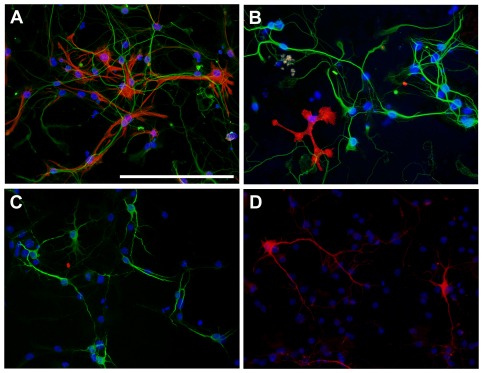
Cellular composition of neuron-astrocyte cultures.Composite fluorescence photomicrographs of neuron-astrocyte cultures that were immuno-stained with A–C) the neuronal marker MAP-2 (green) together with A) astrocyte marker GFAP (red) or B) the microglia marker CD11b (red) or C) the oligondendrocyte marker CNPase (red, not detected). D) Dopaminergic neurons were stained with the dopaminergic neuron marker TH (red). Nuclei were counterstained with DAPI; scale bar is 100 µm.